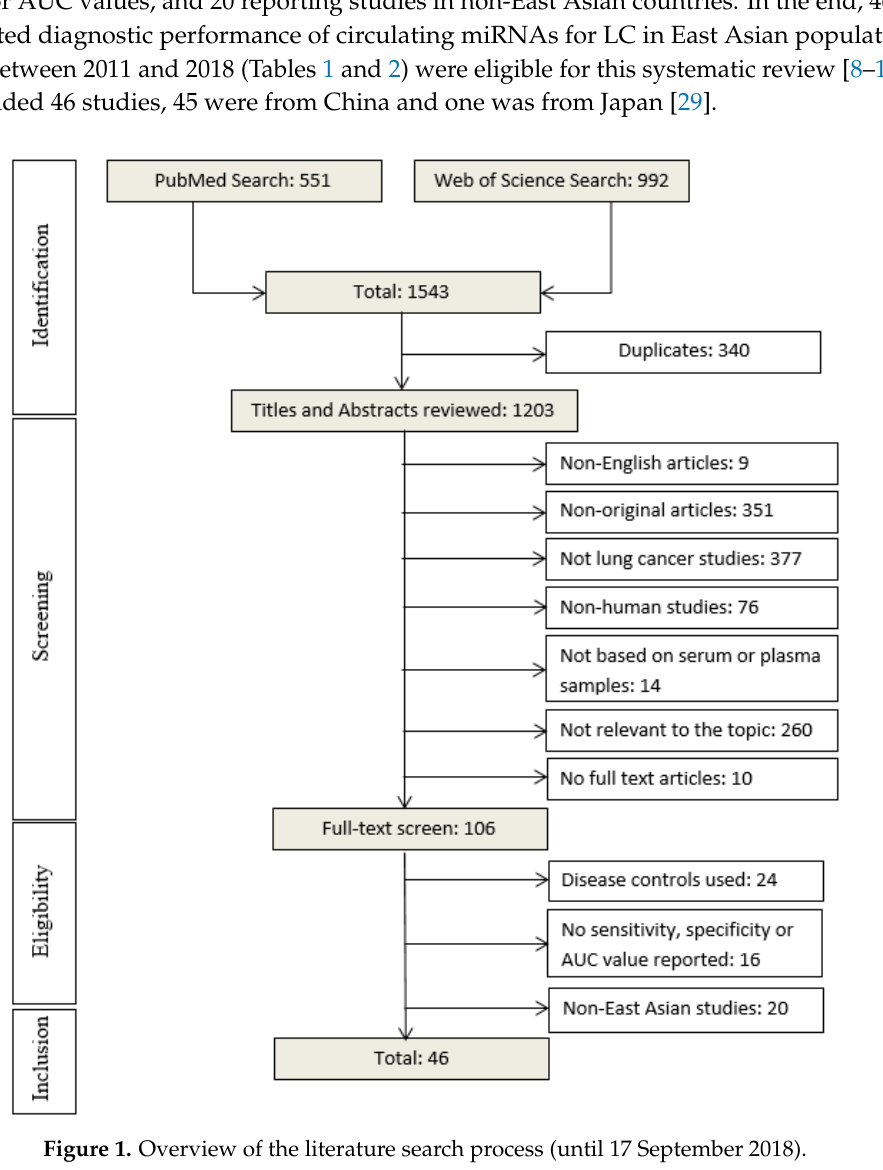
Figure 1. Overview of the literature search process (until 17 September 2018).